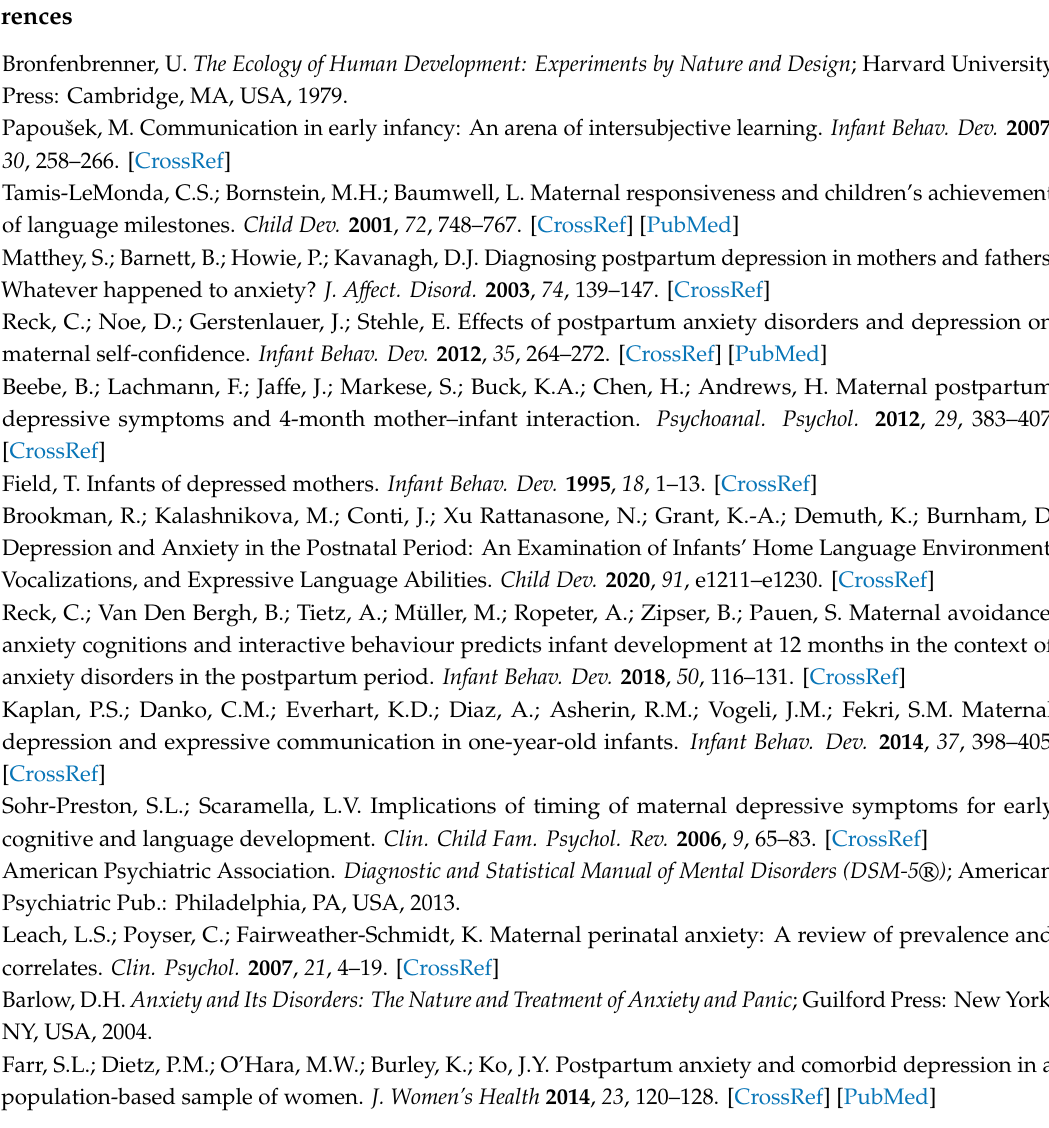
Table S1: Maternal depression and anxiety scores in the control and risk groups; Table S2: Acoustic analysis of auditory